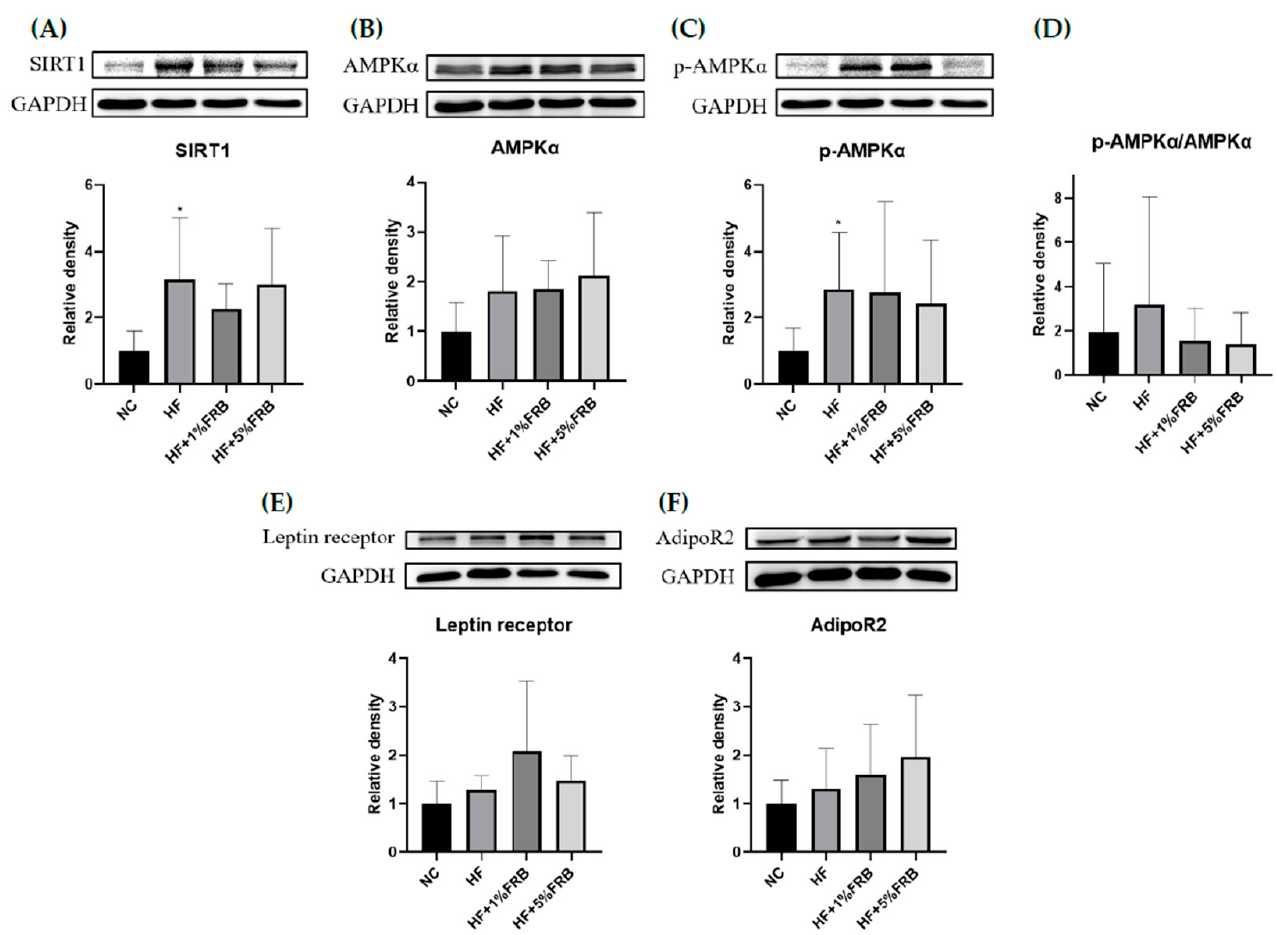
Figure 5. Effects of the water extract of fermented rice bran (FRB) on hepatic lipid metabolism-related protein expressions in aged rats with high-fat (HF) diet feeding. Values are presented as the mean ± standard deviation ( n = 6). * p < 0.05 vs. the normal control (NC) group; significance between two groups was determined using Student’s t -test. In the HF diet-fed groups, significant differences between groups were determined by a one-way ANOVA with Fisher‘s post hoc test. Western blot analysis of ( A ) NAD-dependent sirtuin-1 (SIRT1), ( B ) adenosine monophosphate-activated protein kinase- α (AMPK α ), ( C ) phosphorylated (p)-AMPK α , ( D ) p-AMPK α /AMPK α , ( E ) leptin receptor,